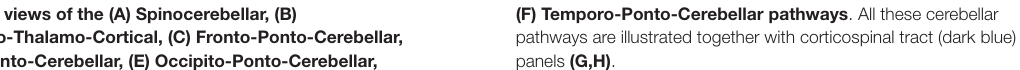
FIGURE 4 | 3D views of the (A) Spinocerebellar, (B) Dentate-Rubro-Thalamo-Cortical, (C) Fronto-Ponto-Cerebellar, (D) Parieto-Ponto-Cerebellar, (E) Occipito-Ponto-Cerebellar,